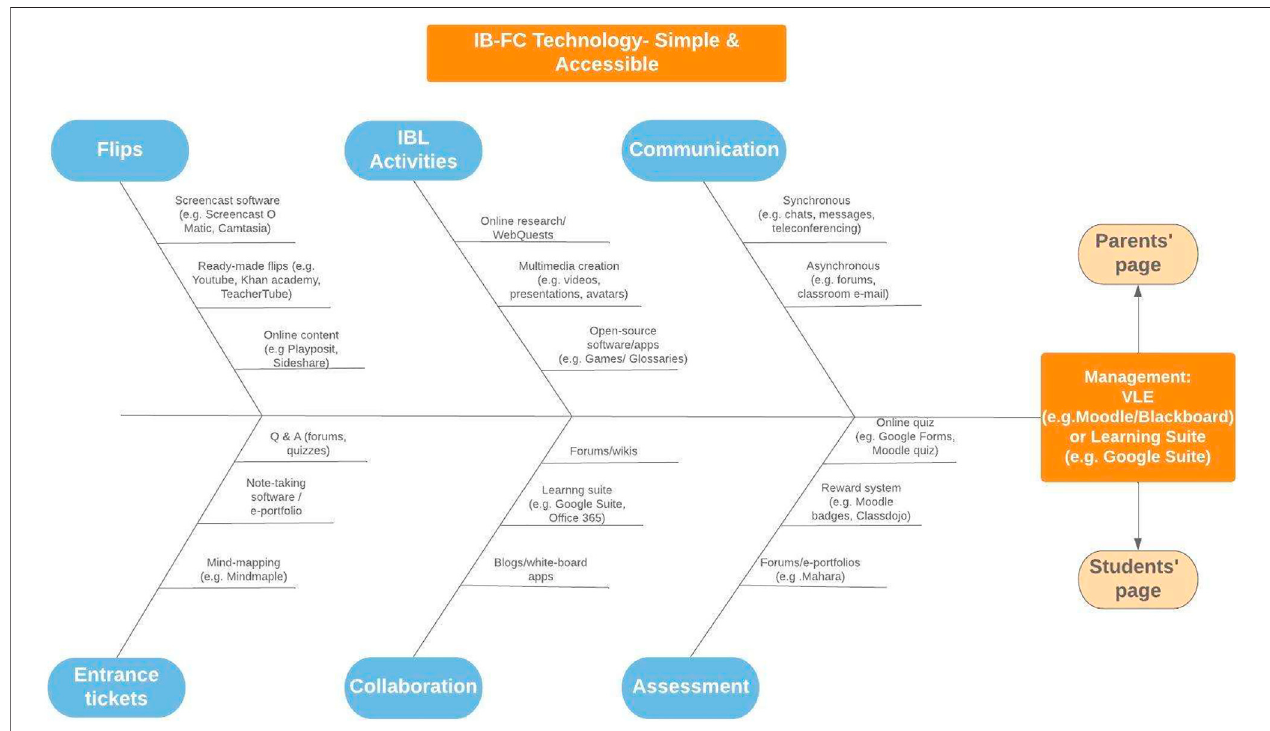
FIGURE 1 | FC Technology tool: Simple and Accessible.